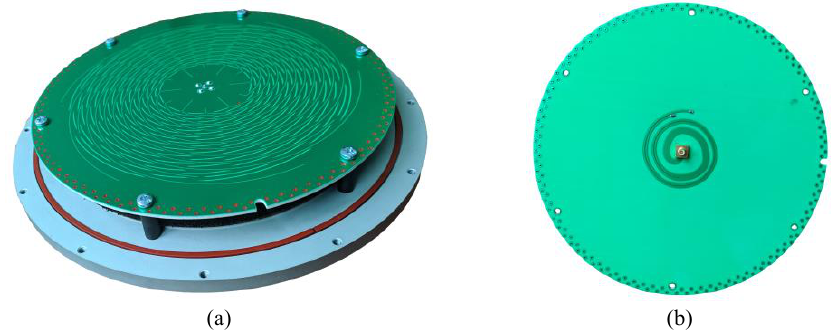
Fig. 7. Photo of the proposed antenna. (a) general layout of the active antenna. (b) back side of the antenna